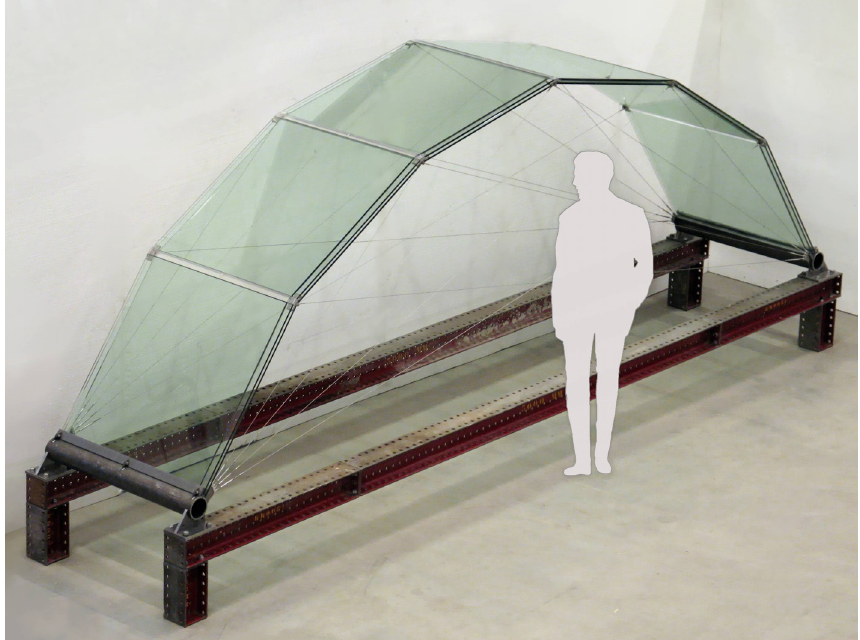
Figure 18: Prototype used for